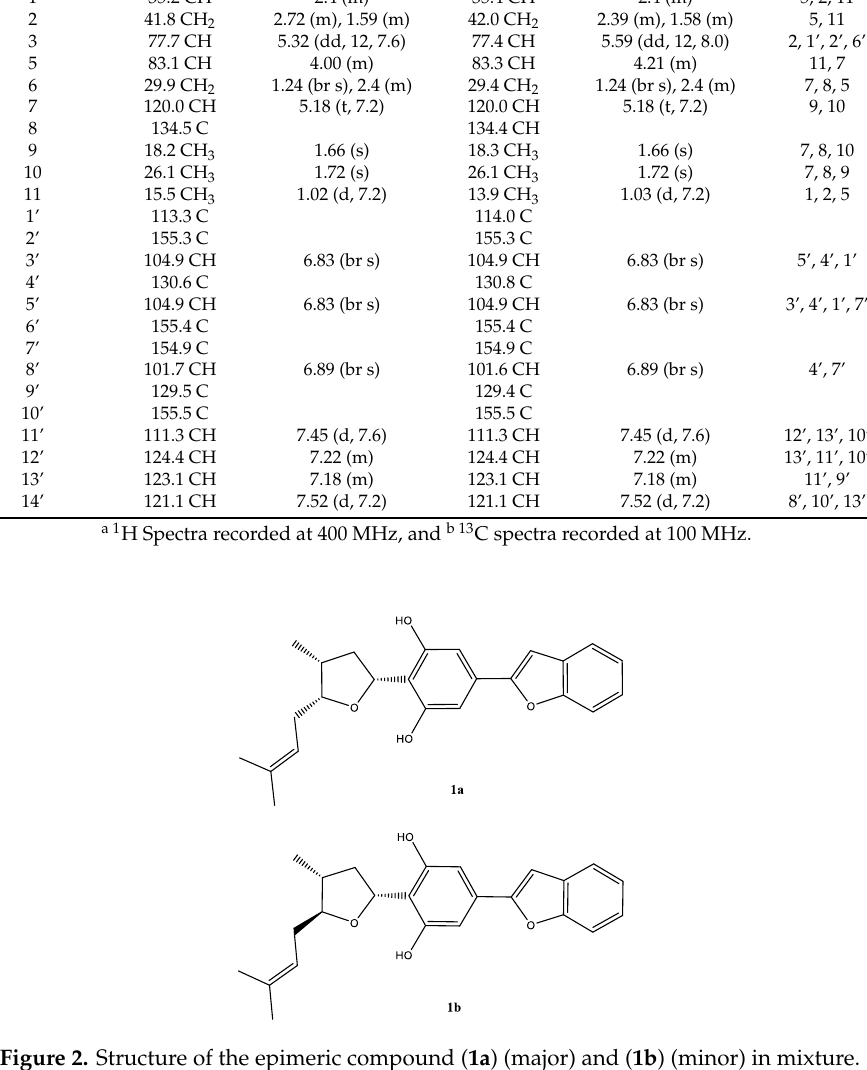
Figure 2. Structure of the epimeric compound ( 1a ) (major) and ( 1b ) (minor) in mixture. Table 1. 1 H and 13 C NMR (in CDCl 3 ) data for epimeric compounds 1a and 1b .